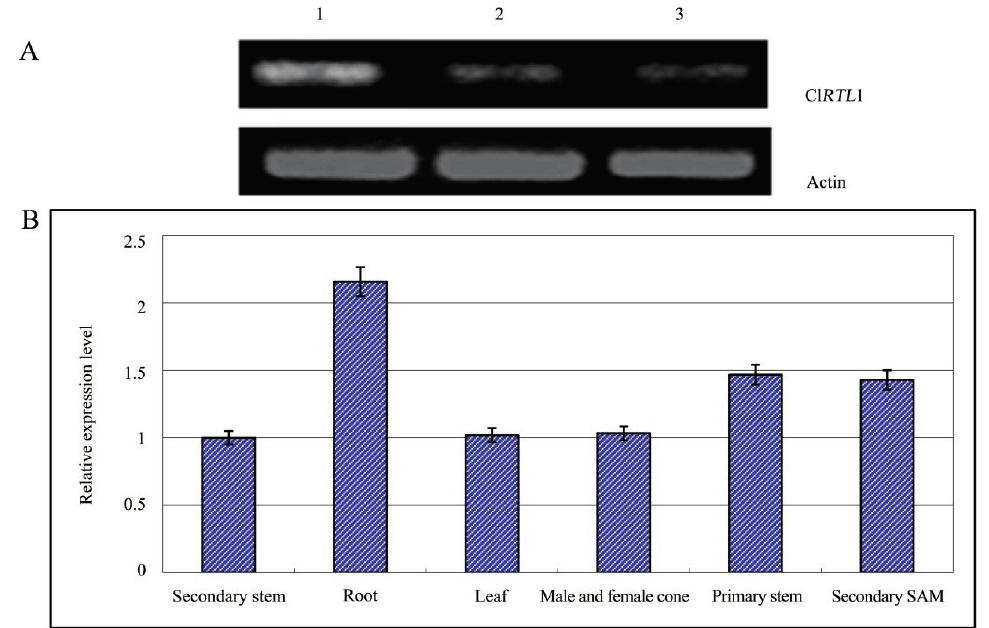
Figure 7. Expression analysis of Cl RTL1 . ( A ) Semi-quantitative expression analysis of Cl RTL1 in three types of SAMs. (1) Primary SAMs of Chinese fir No. 020 that are initiating AMs. The materials were obtained on 6 May; (2) Primary SAMs of Chinese fir No. 020 before AMs initiation. The materials were obtained on 15 April; (3) Primary SAMs of Chinese fir mutant “Dugansha”. The materials were obtained on 6 May; ( B ) Expression analysis of Cl RTL1 in different tissues of Chinese fir. Real-time PCR was conducted using the cDNA of two-year-old Chinese fir as the template. Actin was used for normalization. The error bars indicate the standard deviation. Results were the mean of at least three biological